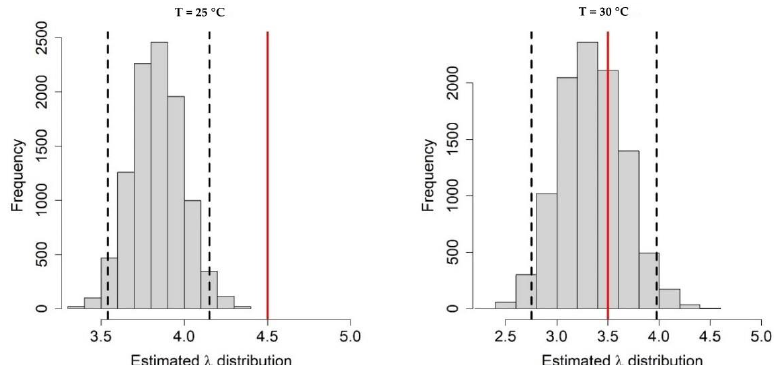
Figure A6. Estimated posterior distributions of Λ G (T), the average duration of gonotrophic cycle at 25 and 30 °C. Dashed black lines represent the 2.5 and 97.5 quantiles. Solid red lines represent the average value for subtropical Ae. albopictus .